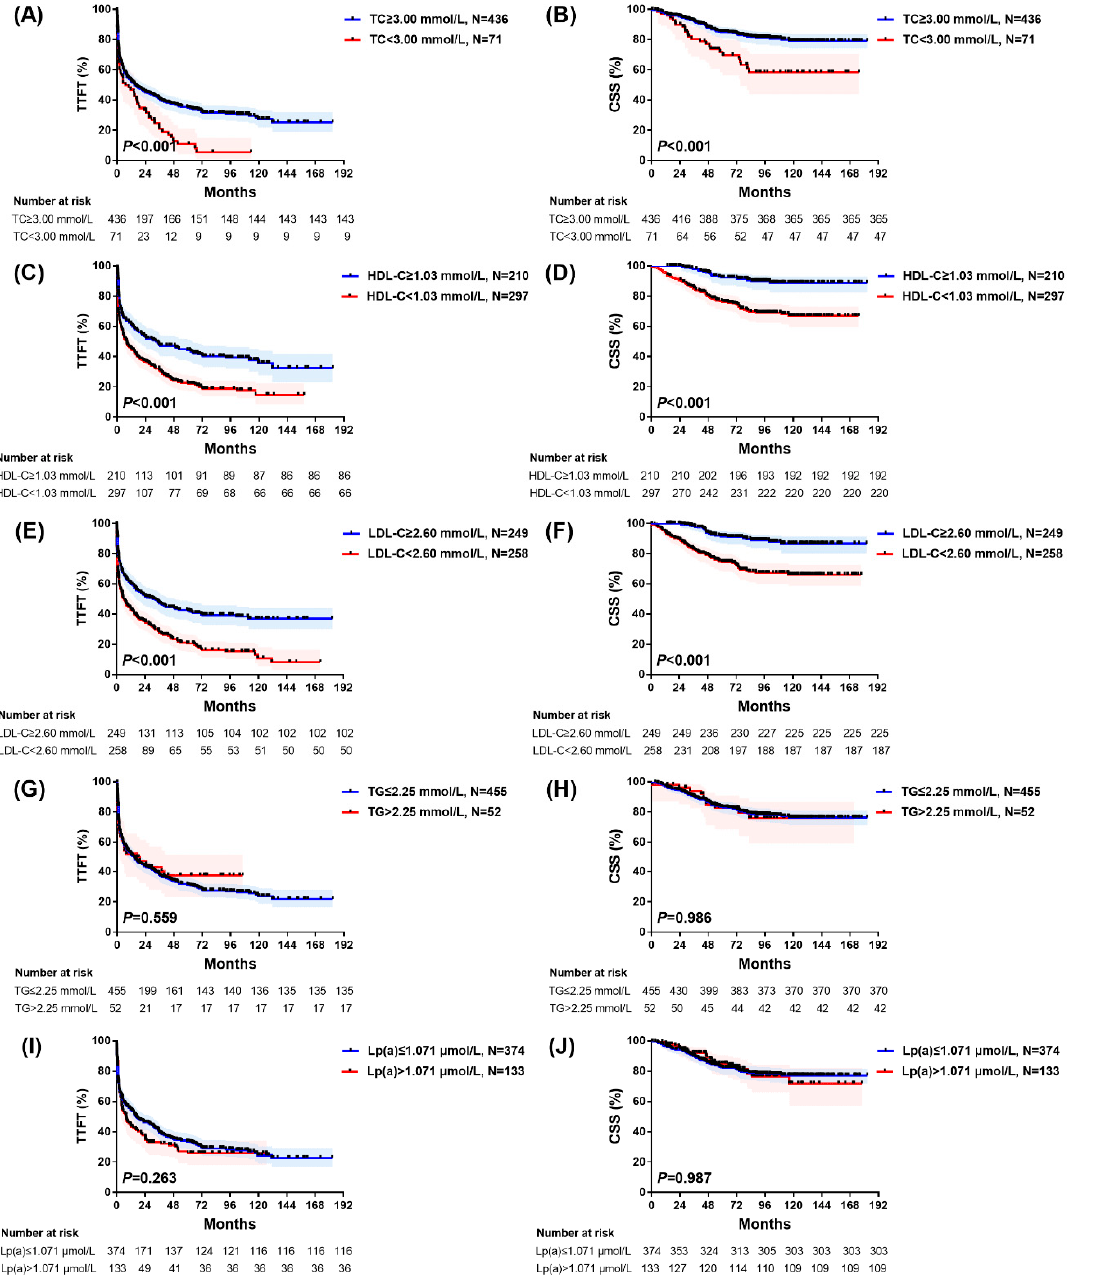
Figure 1. Kaplan–Meier survival curves stratified by serum lipid profile in the primary cohort. Time to first treatment (TTFT) and cancer-specific survival (CSS) in relation to total cholesterol (TC) ( A , B ), high-density lipoprotein cholesterol (HDL-C) ( C , D ), low-density lipoprotein cholesterol (LDL-C) ( E , F ), triglycerides (TG) ( G , H ), and lipoprotein (a) (Lp(a)) ( I , J ).